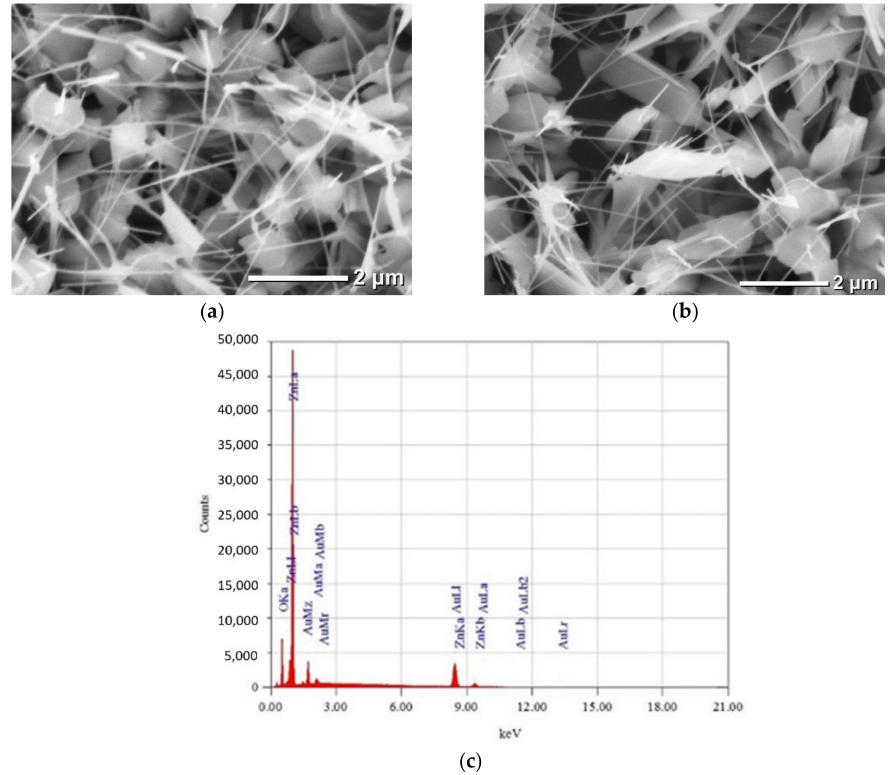
Figure 2. Electron microscopic images of the surface and ERM data of type I ZnO samples—Pure ( a ) and with Au ( b , c ).